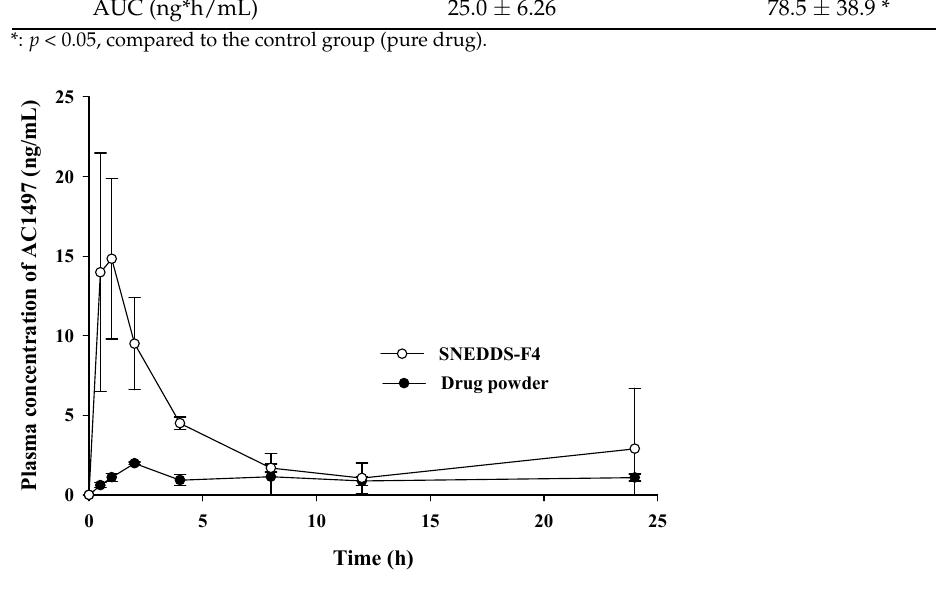
Figure 8. Plasma concentration–time profile of AC1497 following the oral administration of AC1497 in different formulations to rats (mean ± SD, n = 3). The dose was equivalent to 20 mg/kg of AC1497.